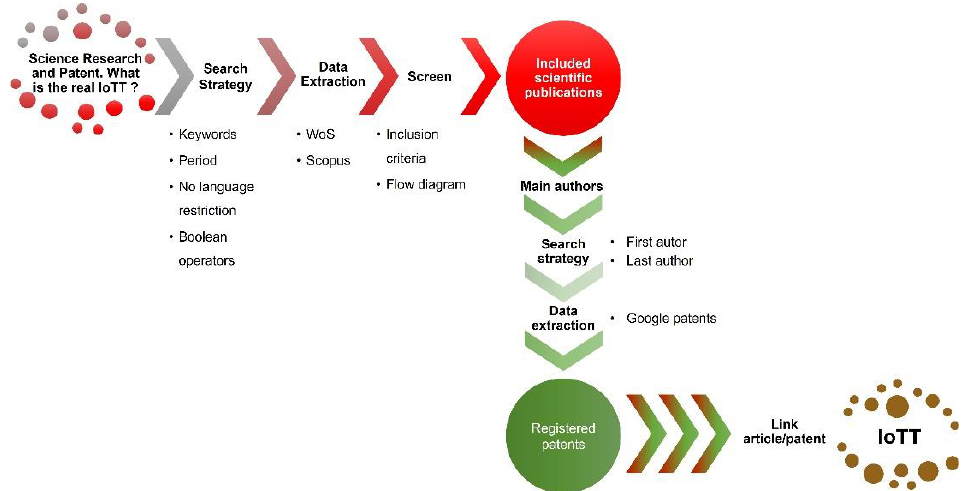
Figure 5. Structure of the used methodology, from the question to answer, to the calculation of the IoTT.